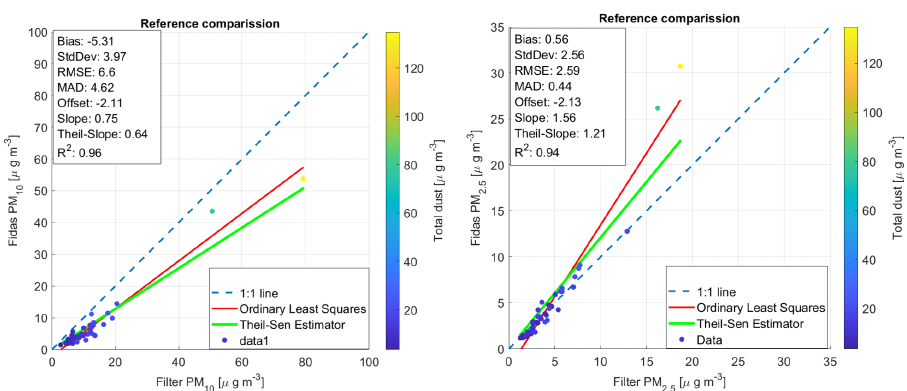
Figure 2. Intercomparison of reference-equivalent (Fidas) to reference (KFG) method of PM 10 and PM 2.5 mass concentration during the co-location period. Axes labels are shown here in units of µg m − 3 . The color scale indicates total suspended dust measured by the FIDAS 200. The blue dashed line indicates the 1:1 reference line, the red line, a linear regression fit to the data, whereas the green line indicates the Theil–Sen estimator. In the top left corner, the corresponding statistics and R 2 value are